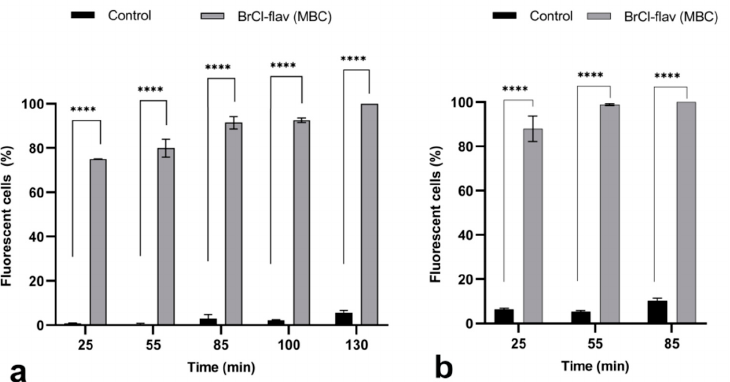
Figure 5. Effect of BrCl-flav exposure on S. aureus medbio1-2012 ( a ) and E. coli medbio4-2013 ( b ) cell membrane integrity. Exponential-phase cells were treated with the antibacterial agent concentration equivalent to MBC and stained with SYTO 9 and propidium iodide. Low levels of fluorescent cells were detected in the untreated control. Red fluorescent cells were detected in samples starting with 25 min of incubation with BrCl-flav, indicating membrane damages. Values are the means of three replicates. Bars indicate SEM. Asterisks denote a significant difference ( p < 0.05) vs. Control (**** = p < 0.0001).